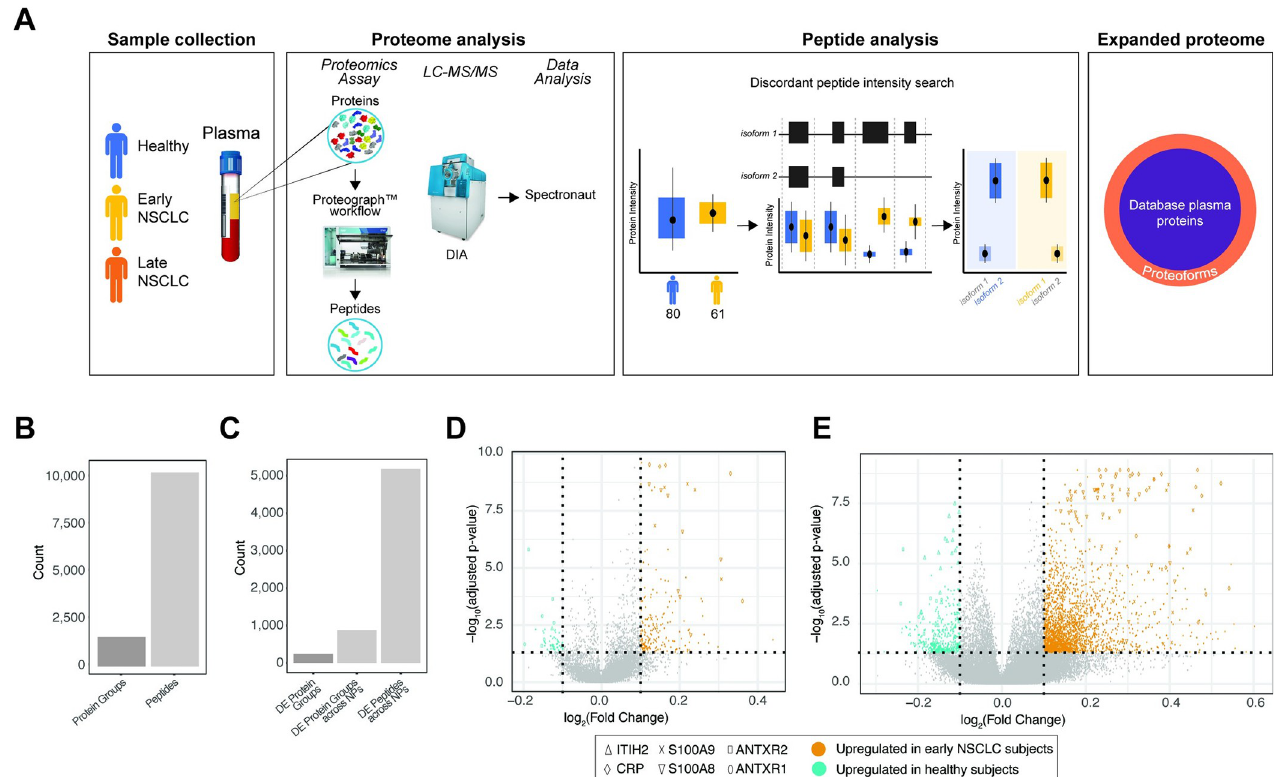
Fig 1. Proteome analysis of healthy and NSCLC subjects using a 5 NP plasma workflow. A. Overview of this proof-of-concept proteoform identification study. Plasma samples were collected from healthy (blue), early non-small cell lung cancer (NSCLC; yellow), late NSCLC (orange), and co-morbid (green) subjects ( Sample Collection ). The plasma proteomes were analyzed for each of these subjects, which included protein extraction, protein discovery using the NP-based Proteograph platform, then DIA protein/peptide identification and quantification using LC-MS/MS and search algorithms ( Proteome Analysis ). Proteoforms were then identified using a discordant peptide intensity search, which included examining peptide mappings to known protein coding isoforms and using differential abundance to discover protein isoforms. Together, these identified proteoforms represent an expanded plasma proteome database not captured in standard MS-based or targeted proteomic studies ( Expanded proteome ). B. Barplots showing the number of peptides and proteins groups retained after filtering to those present in at least 50% of subjects from either heathy or early NSCLC. C. Barplots showing the number of differentially abundant (DA): 1) protein groups, with collapsed abundances using MaxLFQ; 2) protein groups across NPs (i.e., DA independently across NPs); and 3) peptides across NPs. D. Volcano plot showing the significance (adjusted p-value; y-axis) and fold change (x-axis) from calculating the differential abundance of protein groups across NPs between healthy and early NSCLC subjects. Protein groups with a log2(Fold Change) greater or less than 1.0 and adjusted p-value < 0.05 are highlighted, where protein groups with increased abundance in early NSCLC subjects are shown in orange and protein groups with increased abundance in healthy subjects are shown in teal. Proteins with known roles in cancer and immune response (ITIH2, CRP, S100A9, S100A8, ANTXR2, and ANTXR1) are highlighted with various shapes. E. Volcano plot showing the significance (adjusted p-value; y-axis) and fold change (x-axis) from calculating the differential abundance of peptides across NPs between healthy and early NSCLC subjects. Peptides with a log2(Fold Change) greater or less than 1.0 and adjusted p-value < 0.05 are highlighted, where peptides with increased abundance in early NSCLC subjects are shown in orange and peptides with increased abundance in healthy subjects are shown in teal. Peptides mapping to proteins with known roles in cancer and immune response (ITIH2, CRP, S100A9, S100A8, ANTXR2, and ANTXR1) are highlighted with various shapes.